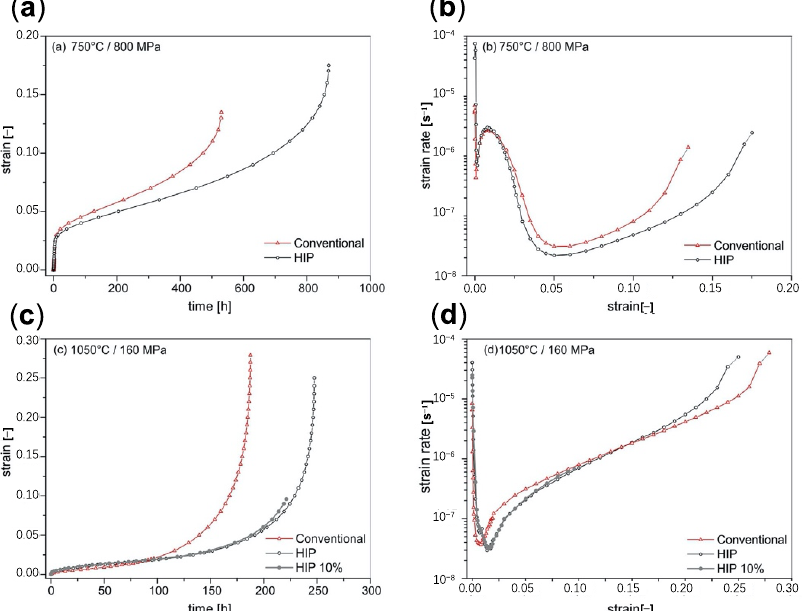
Figure 20. Creep data from five creep experiments performed in the present study. ( a , b ) 750 °C, 800 MPa. ( c , d ) 1050 °C, 160 MPa. ( a , c ) Strain versus time. ( b , d ) Creep rate plotted as a function of strain [32] .